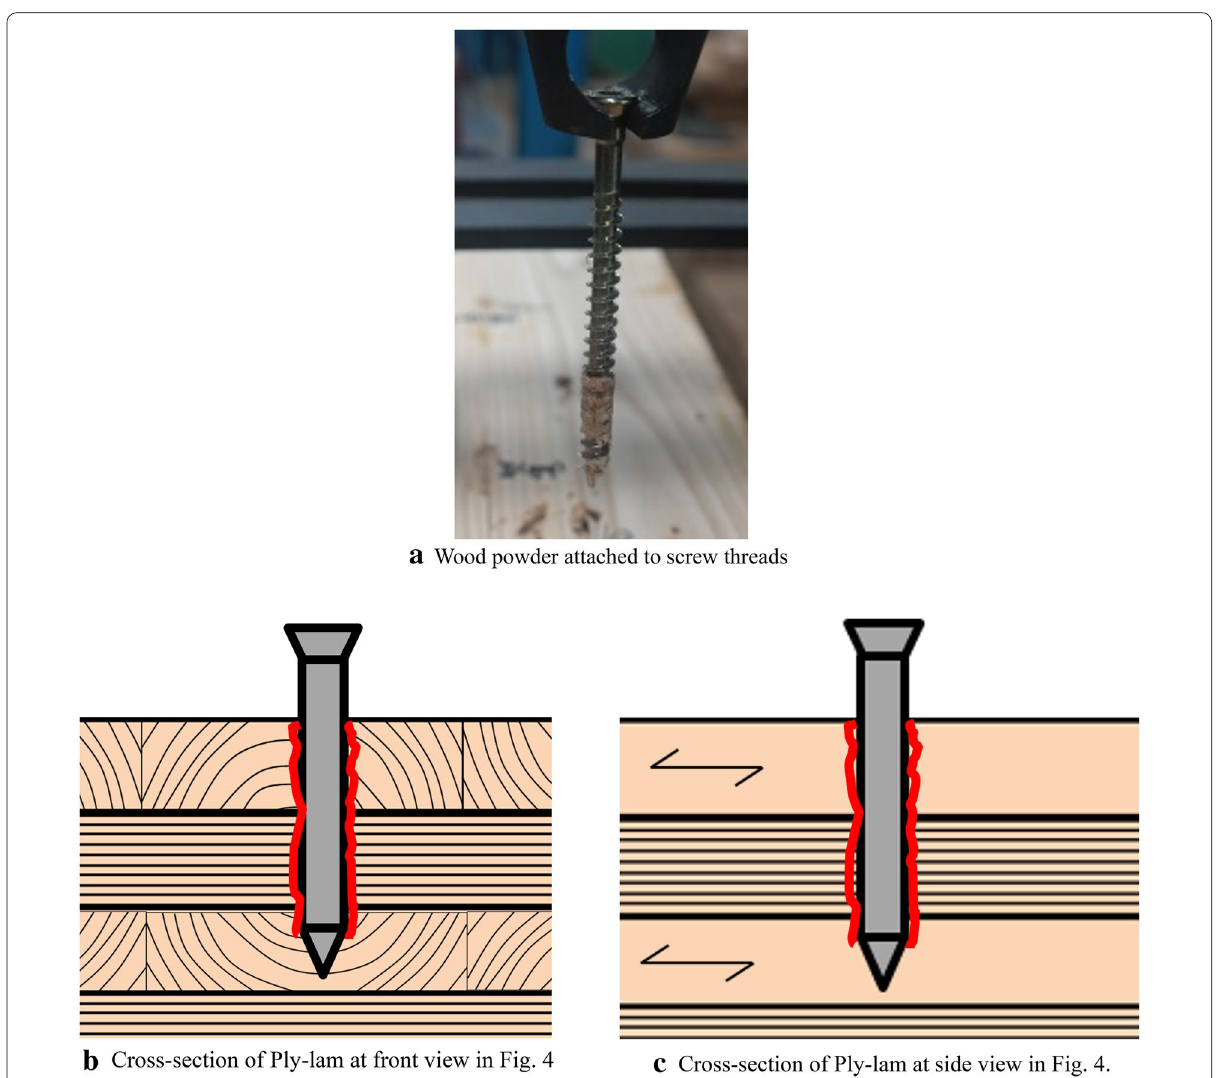
Fig. 7 Shear failure of wood material by thread of